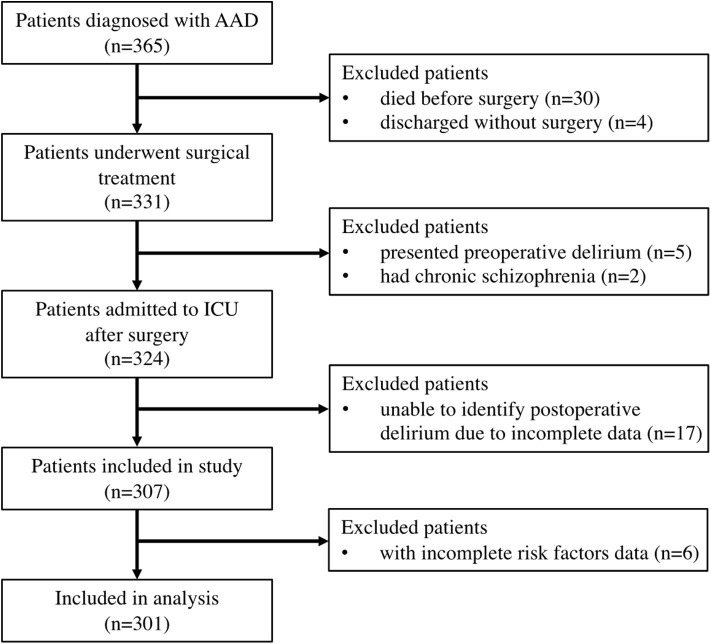
Flow diagram of patient selection.